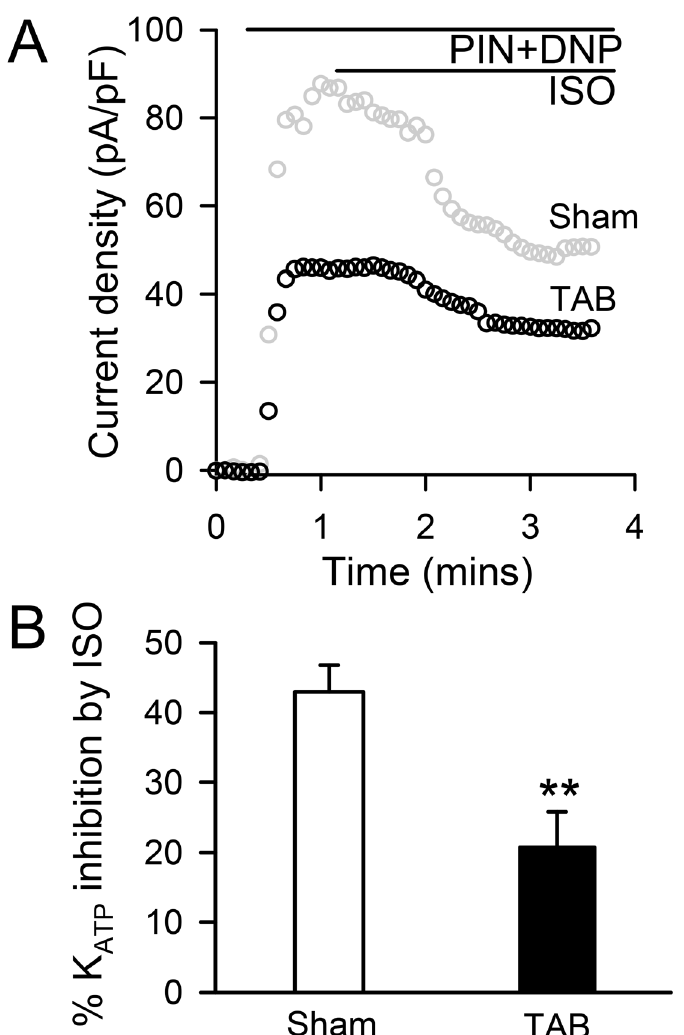
Fig 4. Dynamic downregulation of K ATP channel current density is blunted in ventricular cardiomyocytes of TAB mice. A) Representative tracings of pinacidil (PIN, 100 μ M)- and 2,4-dinitrophenol (DNP, 200 μ M)-stimulated K ATP channel current density in response to isoproterenol (ISO, 1 μ M). B) Summary of percent inhibition of pinacidil and DNP-stimulated K ATP channel current density by isoproterenol (1 μ M) in isolated cardiomyocytes of sham and TAB mice ( ** p < 0.01 vs . sham).